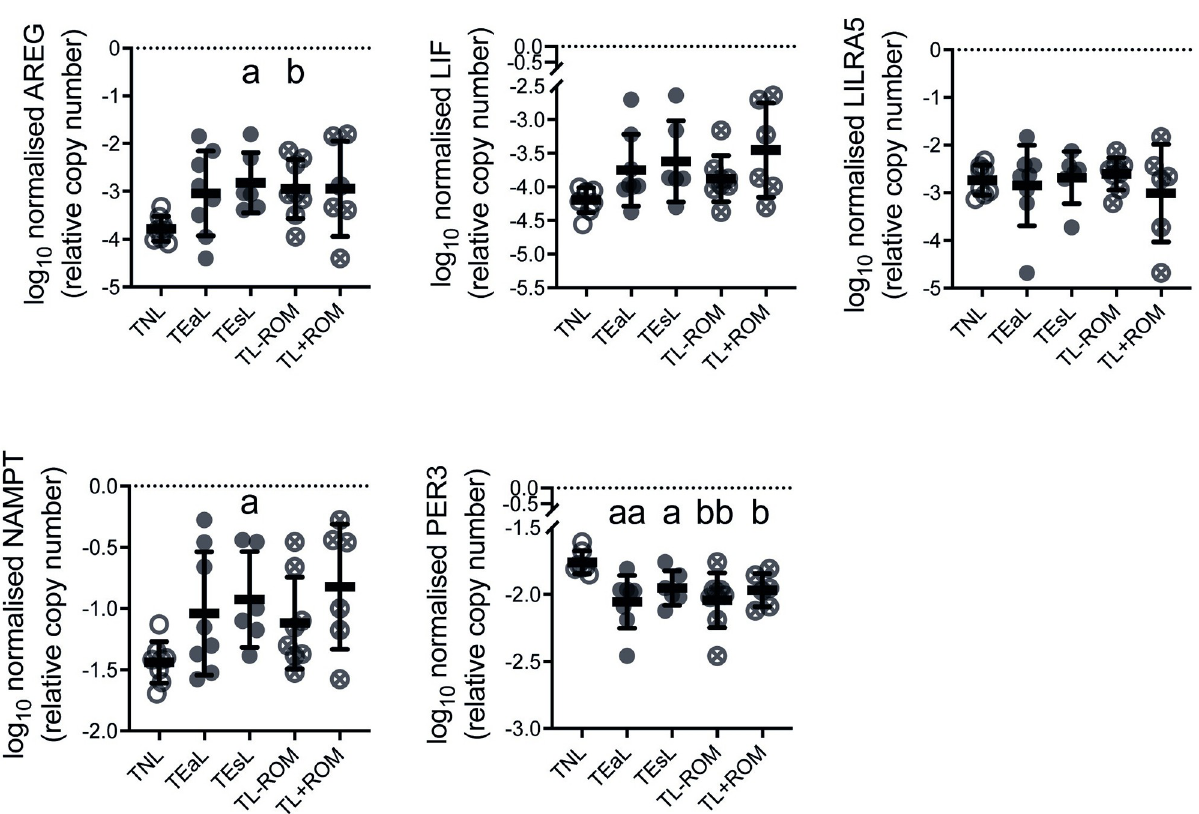
Fig 3. Relative mRNA abundance determined by qPCR for transcriptomics-identified myometrial DEGs common to four labour classifications in RNA-seq cohort tissues. Log 10 transformed qPCR data (mean with standard deviation; n = 6–8) for myometrial mRNA levels of genes identified by RNA-seq (Fig 2) to be differentially expressed (DEGs) for all four classifications of labour, when compared to the non-labouring state (TNL), in the same biopsies. For cervical dilatation, labour was classified as early ( � 3 cm; TEaL) or established ( > 3 cm; TEsL) at time of Caesarean section. These TEaL and TEsL samples were alternatively classified by fetal membrane rupture (ROM) status, whereby either ROM was absent (TL-ROM) or present (TL+ROM) for > 1 hour prior to fetal delivery, to assess the effect of ROM irrespective of cervical dilatation. All data for DEGs of interest were normalised to both β 2-microglobulin ( B2M ) and ribosomal protein L19 ( RPL19 ). Brown-Forsythe & Welch ANOVA (Dunnett’s T3 post-hoc ) was used for statistical analyses of TEaL / TEsL vs TNL ( a p � 0.05, aa p � 0.01) and TL-ROM / TL+ROM vs TNL ( b p � 0.05, bb p � 0.01).